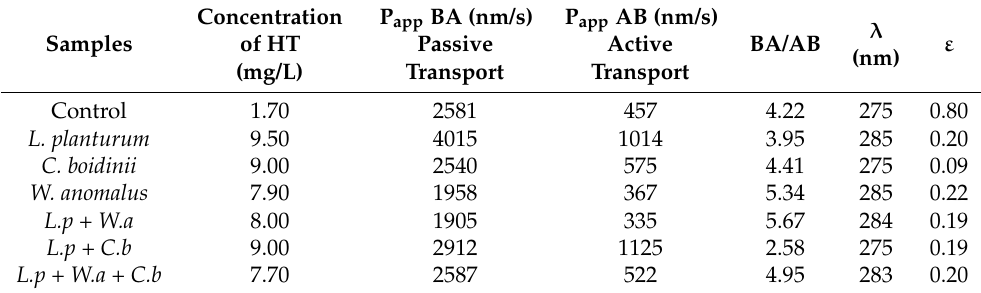
Table 3. Apparent permeability of different samples of